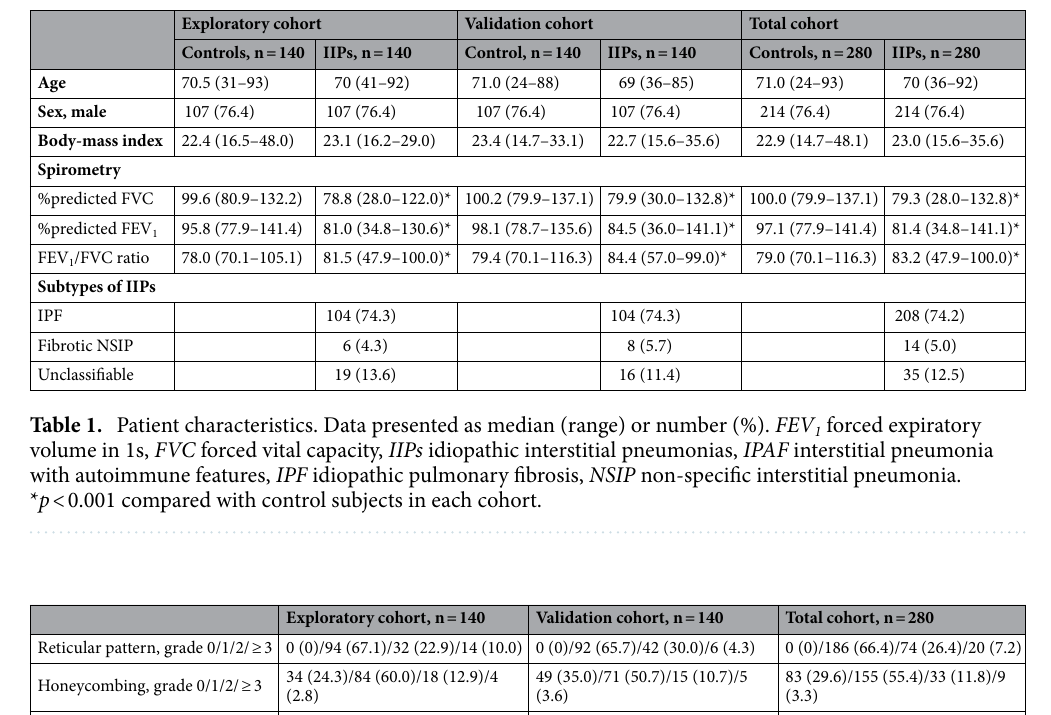
Exploratory cohort, n = 140 Validation cohort, n = 140 Total cohort, n = 280 Reticular pattern, grade 0/1/2/ ≥ 3 0 (0)/94 (67.1)/32 (22.9)/14 (10.0) 0 (0)/92 (65.7)/42 (30.0)/6 (4.3) 0 (0)/186 (66.4)/74 (26.4)/20 (7.2) Honeycombing, grade 0/1/2/ ≥ 3 34 (24.3)/84 (60.0)/18 (12.9)/4 (2.8) 49 (35.0)/71 (50.7)/15 (10.7)/5